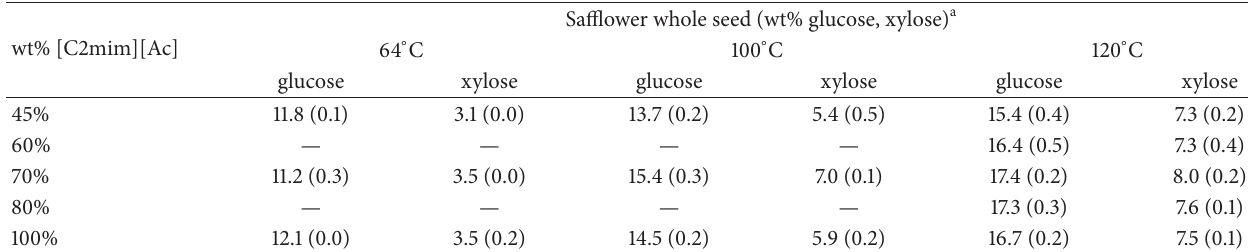
Table 1: Weight percent fermentable sugars recovered from safflower whole seeds pretreated with [C2mim][Ac]-MeOH at 64, 100, and 120 ∘ C. Yields are reported relative to weight of whole seed.